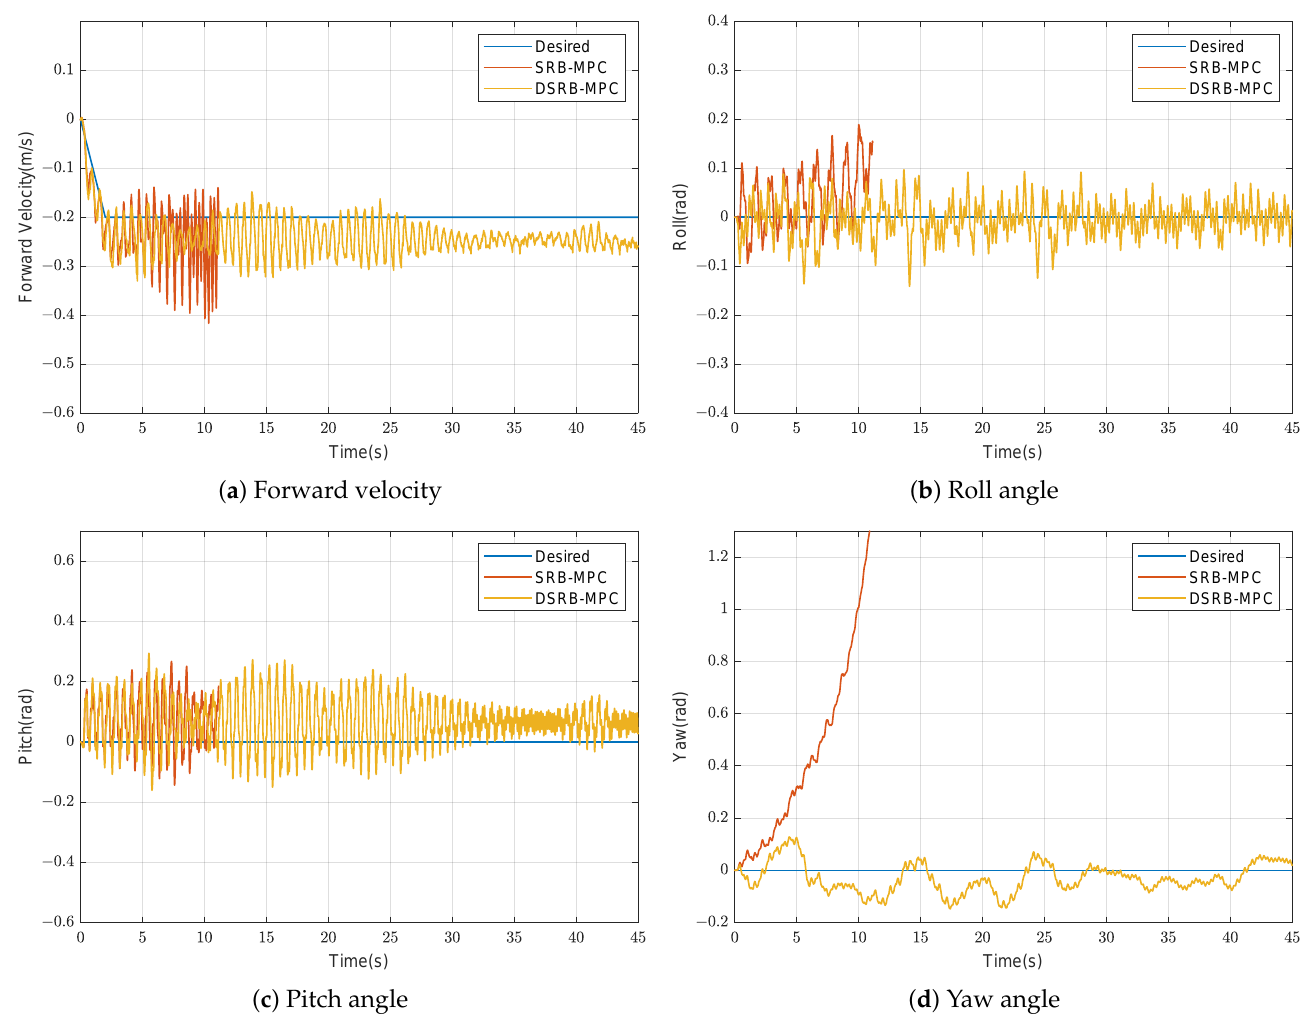
Figure 10. The performance of moving in the opposite direction. ( a ) The command velocity and measured actual velocities of are presented. ( b ) The command roll angle and measured actual roll angles are presented. ( c ) The command pitch angle and measured actual pitch angles are presented. ( d ) The command yaw angle and measured actual yaw angles are presented. Note that all blue lines represent given reference signals. Red lines show the performance of SRB-MPC. Yellow lines show the performance of DSRB-MPC. The red line stops because the error of SRB-MPC exceeds the maximum error, the simulation stops at about 10 s. The reason for the instability of SRB-MPC is that the disturbances of the swinging leg are not considered in the modeling, and the modeling error is too large. In this situation, modeling errors for roll and yaw are too large, and MPC cannot resist. However, DSRB-MPC can accurately model disturbances and resist